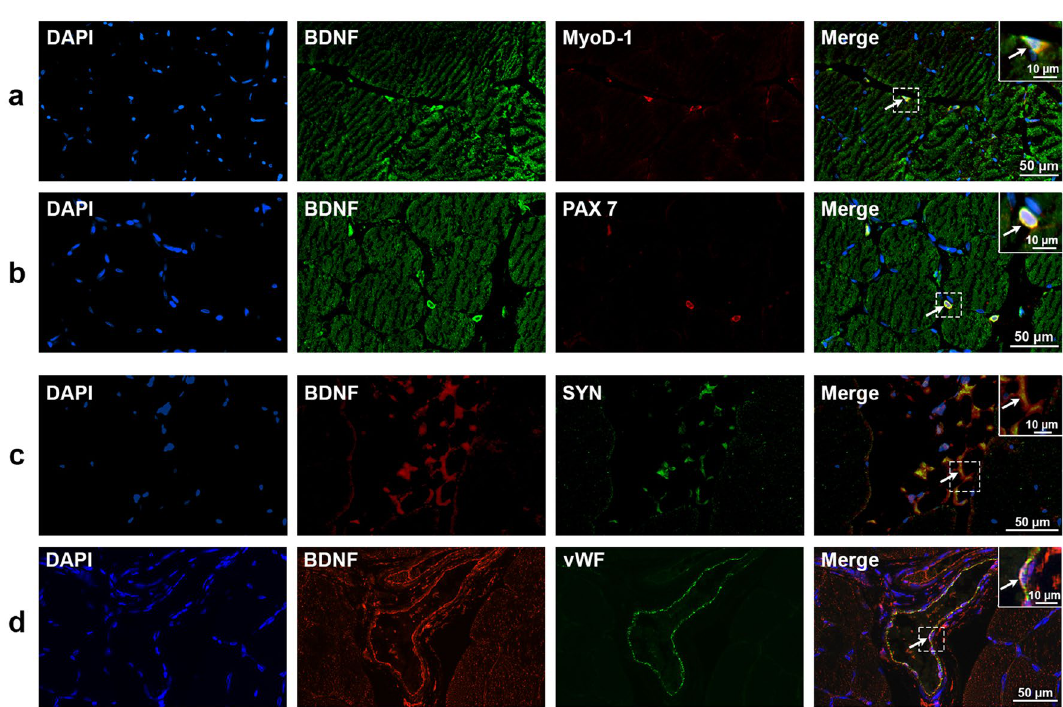
Figure 2. Colocalization of BDNF with specific markers of satellite (MyoD-1, myoblast determination protein 1/PAX 7, Paired box 7) cells, axonal processes of motor neurons (SYN, synaptophysin) and endothelial (vWF, von Willebrand factor) cells in soleus (SOL) muscle. DAPI (blue) was used as nuclear marker. BDNF was stained either in green ( a, b ) or in red ( c, d ), MyoD-1 and PAX 7 were marked in red ( a, b ) and, SYN and vWF in green ( c, d ). Similar results were observed in all examinations ( n = 4). The inserts show with higher magnification the colocalization of BDNF with each specific marker in presence of DAPI. Scale bar 50 µm (10 µm, for the